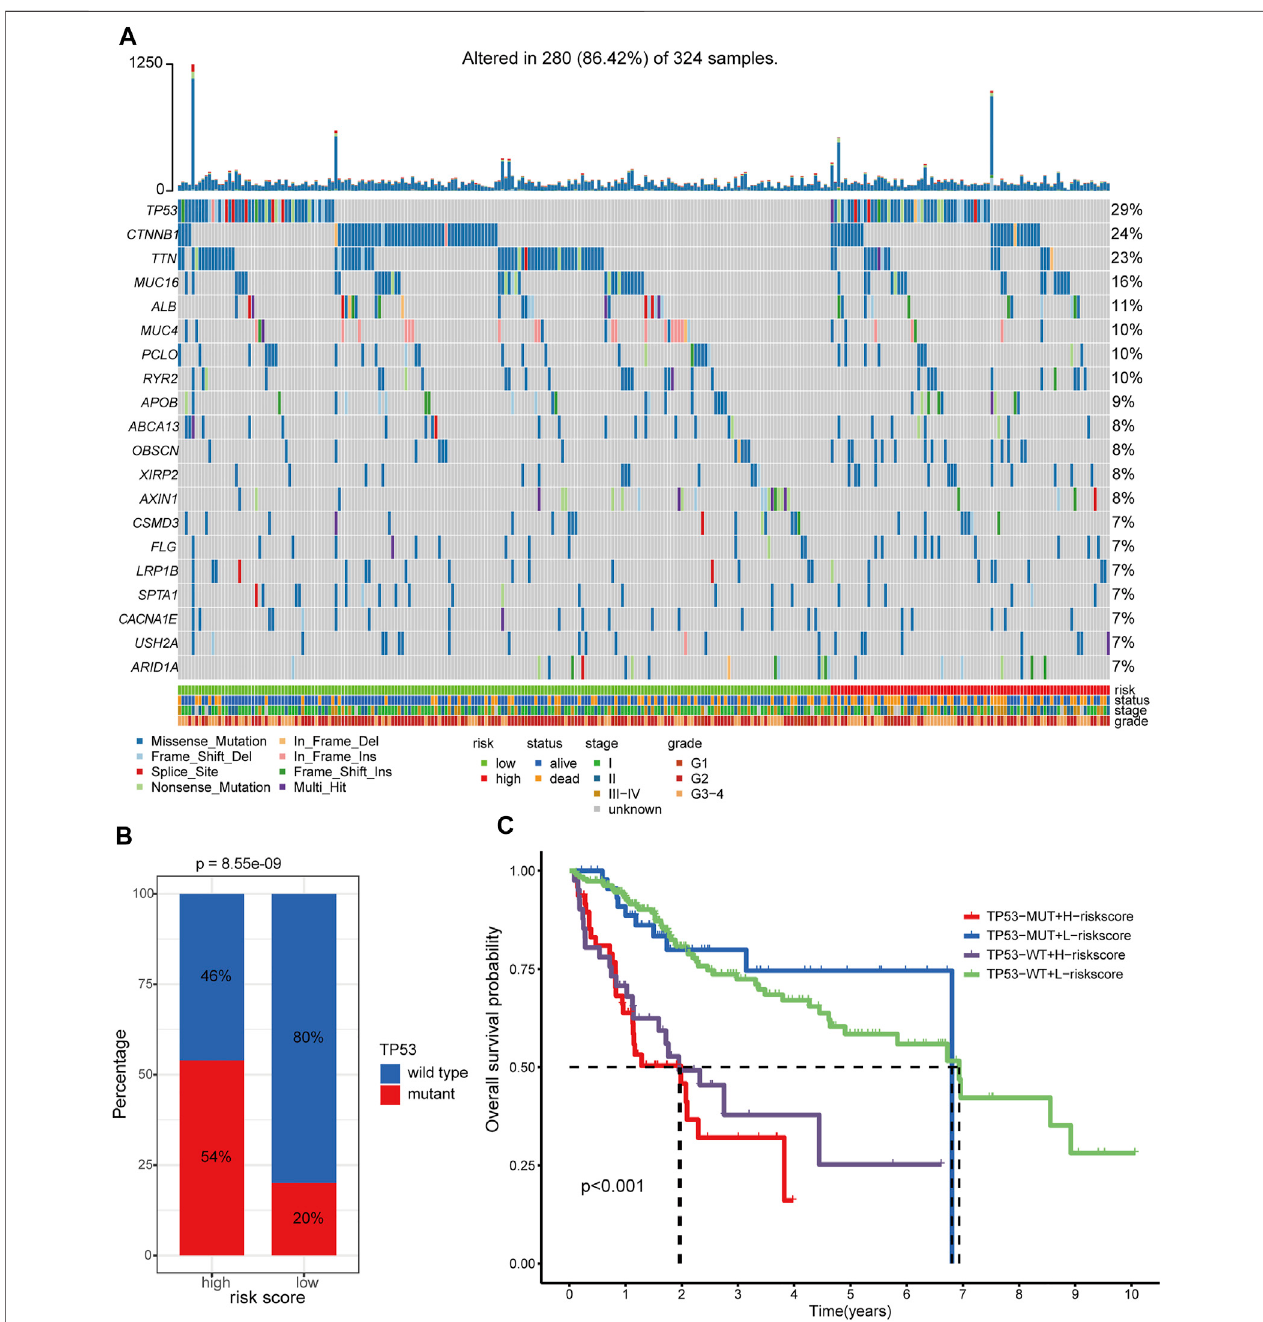
FIGURE 10 | Somatic variants analysis of patients in TCGA-LIHC cohort. (A) Somatic variants landscape of the top 20 frequently mutational genes in the two risk groups. (B) ComparisonofmutationalfrequencydifferencesofTP53betweenhypoxia-relatedhigh-riskandlow-riskgroups. (C) Survivalanalysesofthedifferentclinical subgroups strati fi ed by TP53 status and hypoxia-related risk score. TP53-MUT: TP53-mutant. TP53-WT: TP53-wild type. H-risk score: high-risk score. L-risk score: low-risk score.